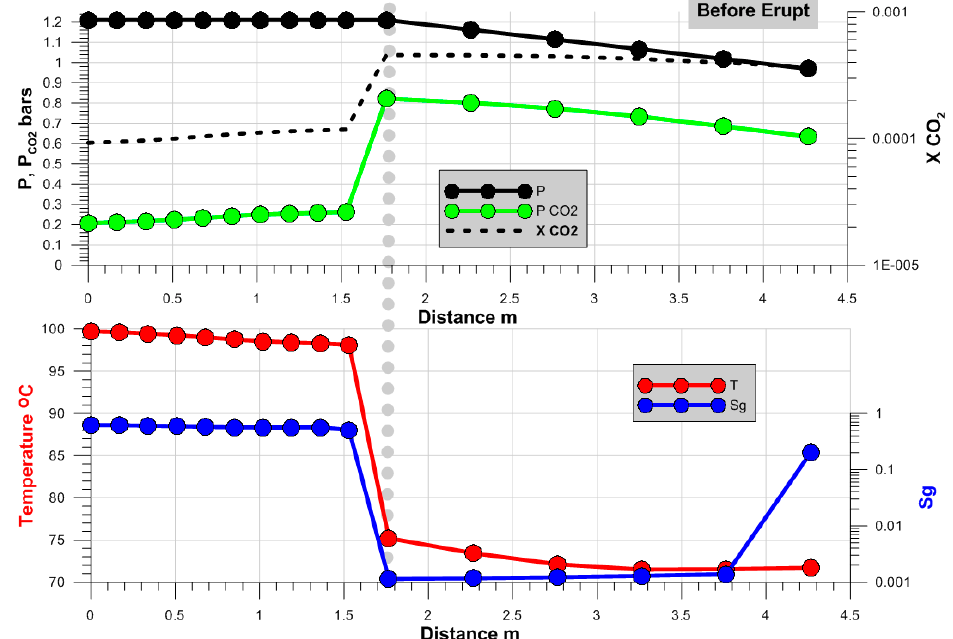
Figure 10. State before eruption (run #9B): model parameter distributions (temperature in °C, gas saturation Sg, pressure and partial CO 2 pressure P CO2 in bars, mass fraction of CO 2 in a liquid phase) along a streamline from hot water recharge element #11 to discharge element #56 of the model (see Figure 7 for model element name references). Vertical dotted line corresponds to the position of flow direction change from radial-horizontal to ascending-vertical. Geosciences 2019 , 9 , x FOR PEER REVIEW